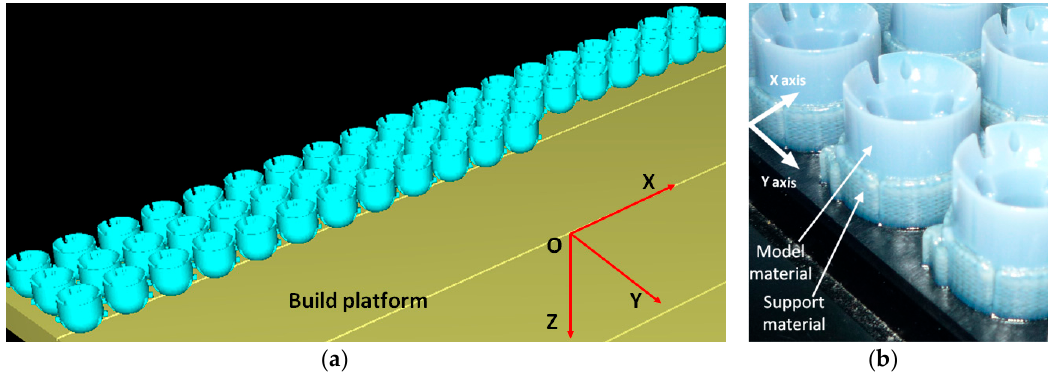
Figure 3. ( a ) Layout of the EDEN 350 build platform illustrating the 50 parts patterned in an array. ( b ) Detail of the printed specimens on the build